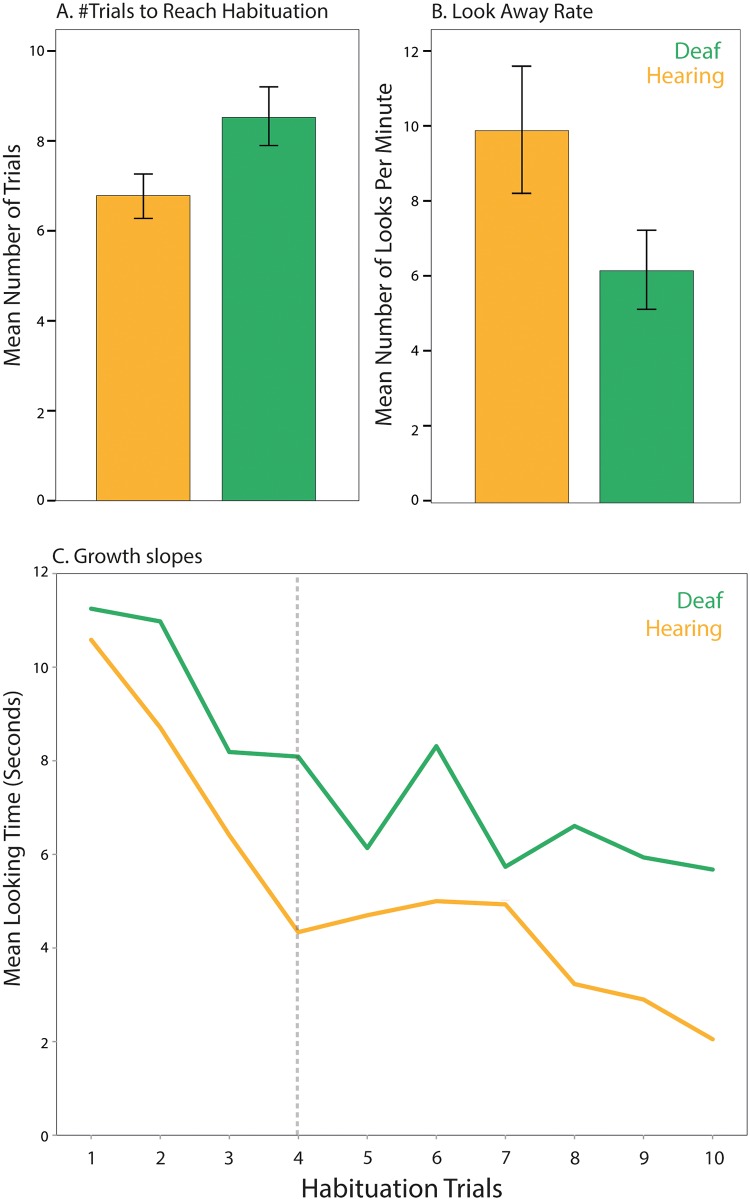
Visual habituation in deaf and hearing infants.[A] Deaf infants required more trials to reach the habituation criterion and [B] demonstrated lower look-away rates across habituation trials than their age-matched hearing peers. [C] Deaf infants demonstrated a shallower slope on the first four habituation trials. Note that data points after the fourth habituation trial are based on increasingly fewer infants and a different number of infants per group and should thus be interpreted with caution.